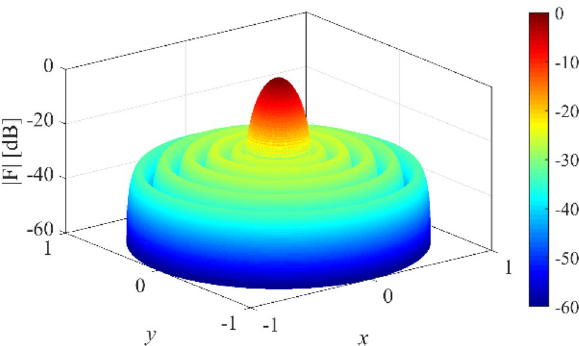
Figure 15. The obtained 3D pattern of the fourth case.